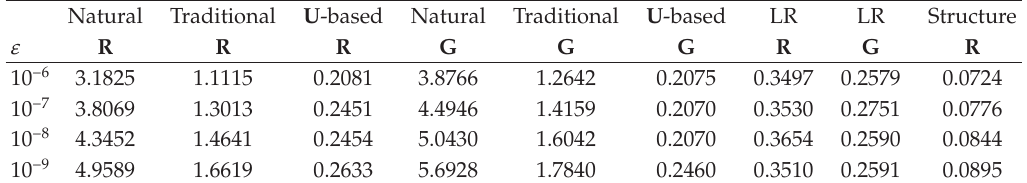
Table 2: Time in seconds required for di ff erent methods to execute for interarrival times having probability